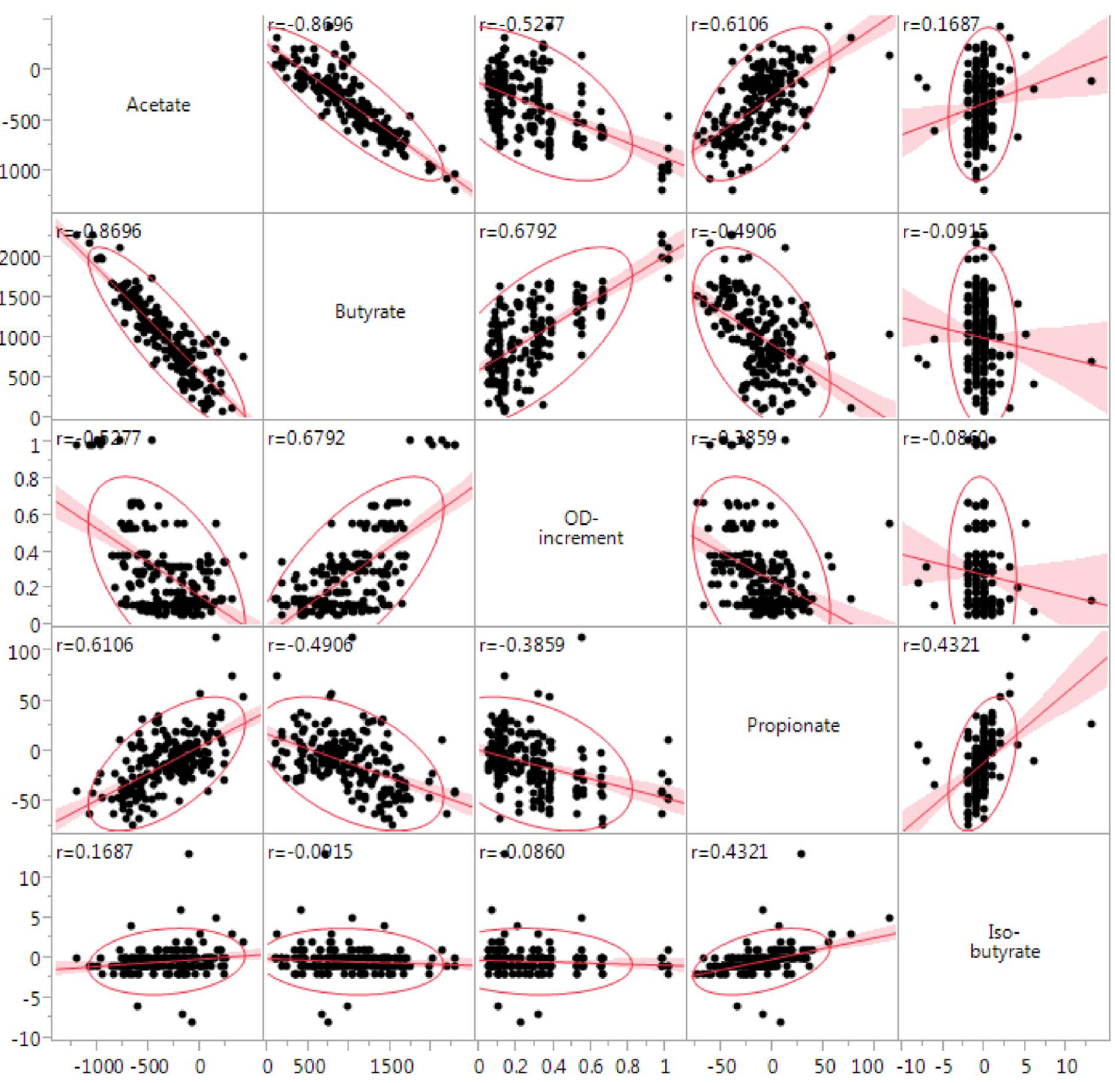
Fig. 4. Correlations between the average difference of short chain fatty acids (acetate, butyrate, propionate and isobutyrate) concentrations and the growth performance of the F. prausnitzii isolates, represented by the increment of optical density. Correlation coefficients and fitted lines with confidence intervals are shown in each